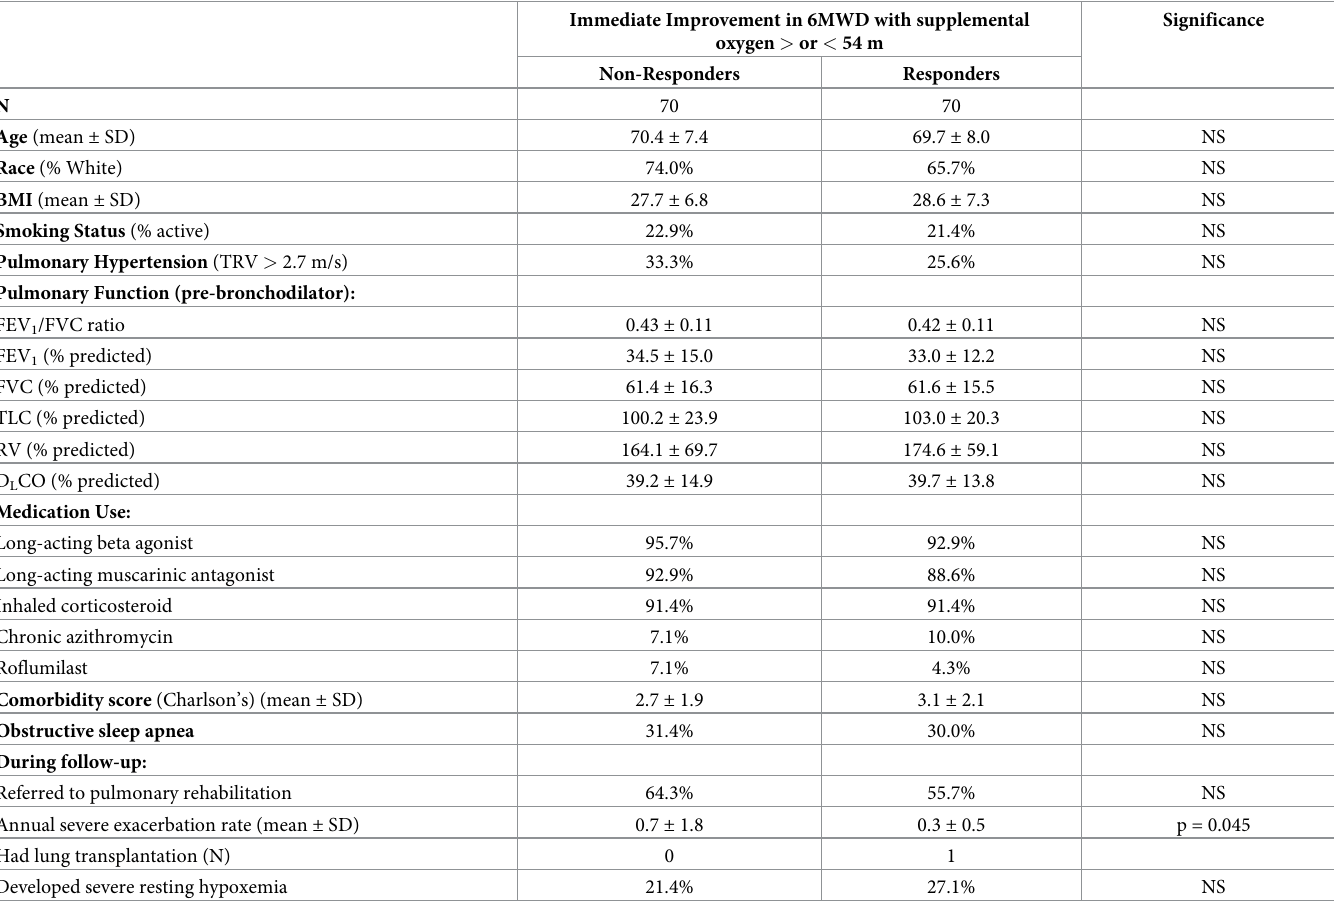
Table 1. Comparison of clinical and demographic characteristics between subjects with exertional hypoxemia with and without immediate improvements in 6MWD with supplemental